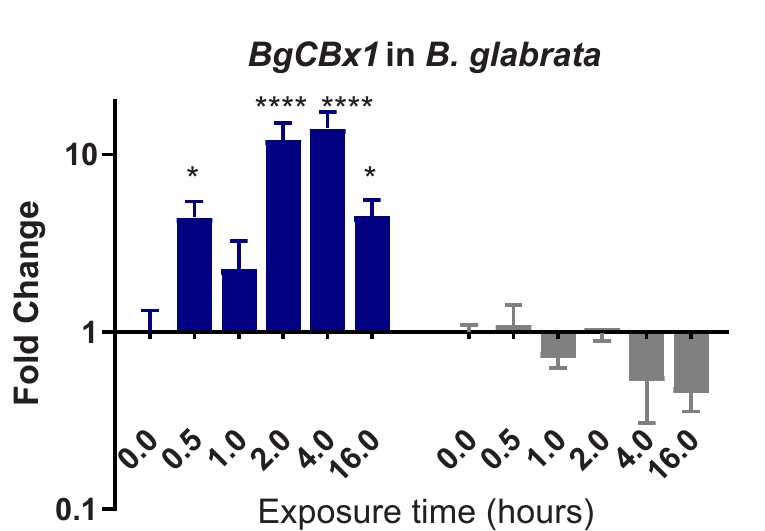
Fig 3. qPCR analysis of RNA from either resistant BS-90 (blue histogram) or susceptible BBO2 (gray histograms) juvenile snails unexposed (0) or exposed for increasing intervals (30 seconds to 16 hours) S . mansoni miracidia. Histograms show expression of the BgCBx encoding transcript in snails at each time point from five biological replicates. Note the increase in fold change in the resistant BS-90 compared to the susceptible BBO2 snails after parasite infection. Significant expression normalized against expression of the myoglobin encoding transcript was measured by 2-way ANOVA and is indicated by number of asterisks on each histogram where ���� , indicates the most significant value p � 0.0001, ��� p � 0.001, �� p � 0.01, � p � 0.05, ns p >